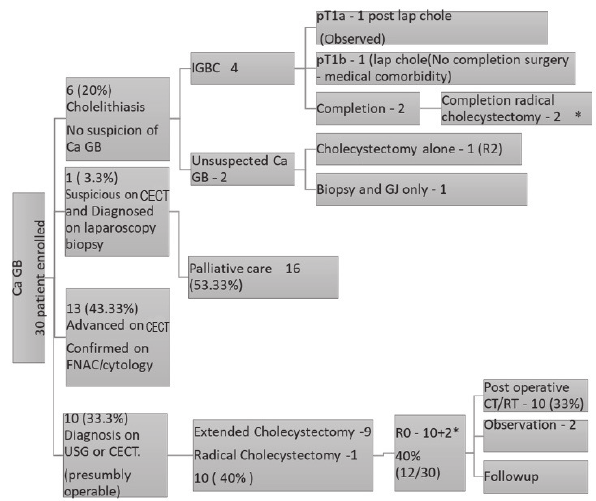
CECT- Contrast Enhanced Computed Tomography, CT-chemotherapy,